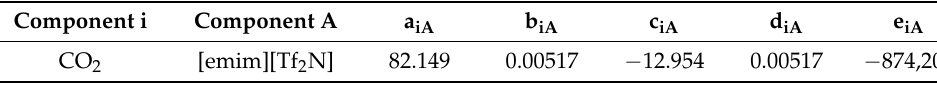
Table 2. Parameters of temperature-dependent Henry constants.